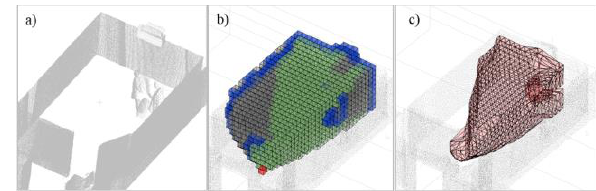
Figure 9. a) Point cloud, b) voxel representation, c) 3D isovist of Test A for mid-peripheral visual angle. People in the interior of the room cause occlusion.